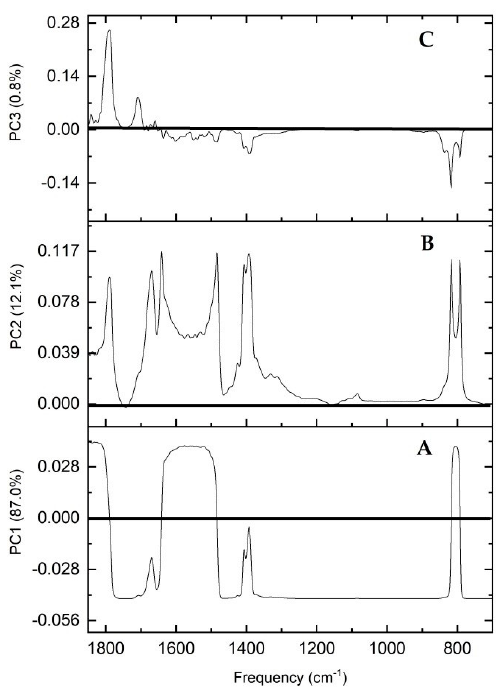
Figure 6. The loading factors of PCA: ( A ) PCA1; ( B ) PCA2; ( C ) PCA3